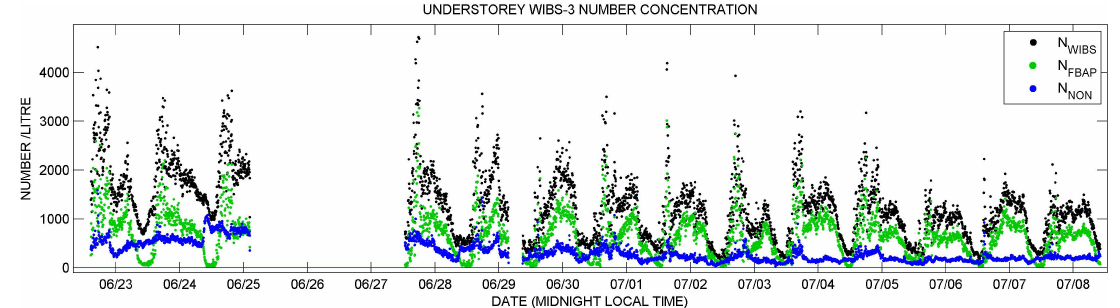
Fig. 4. Understorey time series of N WIBS , N FBAP and N NON , June–July 2008. The gap from 25–27 June represents instrument downtime.